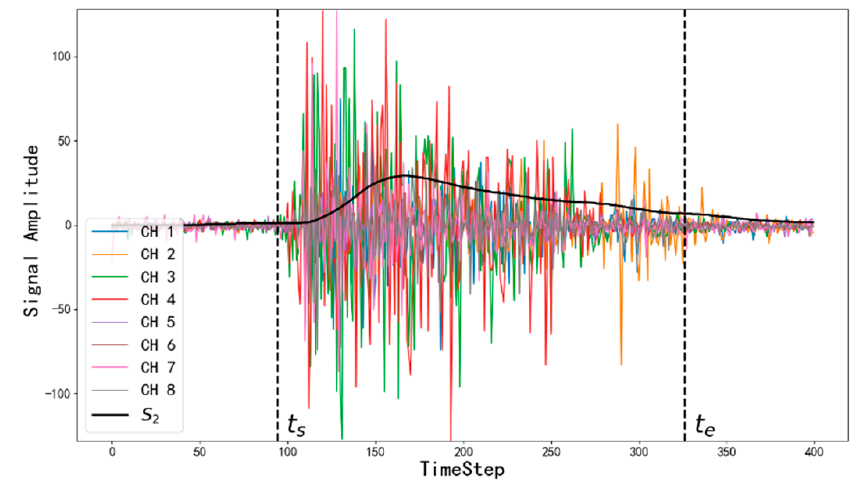
Figure 4. The curves of surface electromyographic (sEMG) signals and the motion detection result.